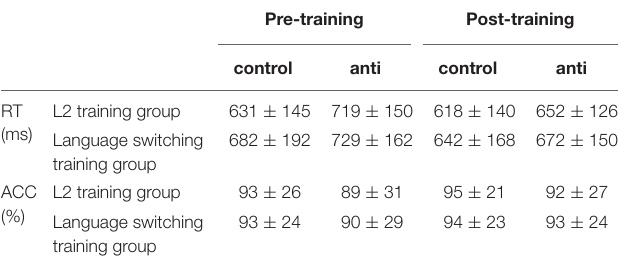
eventually improve the specific monitoring or inhibitory